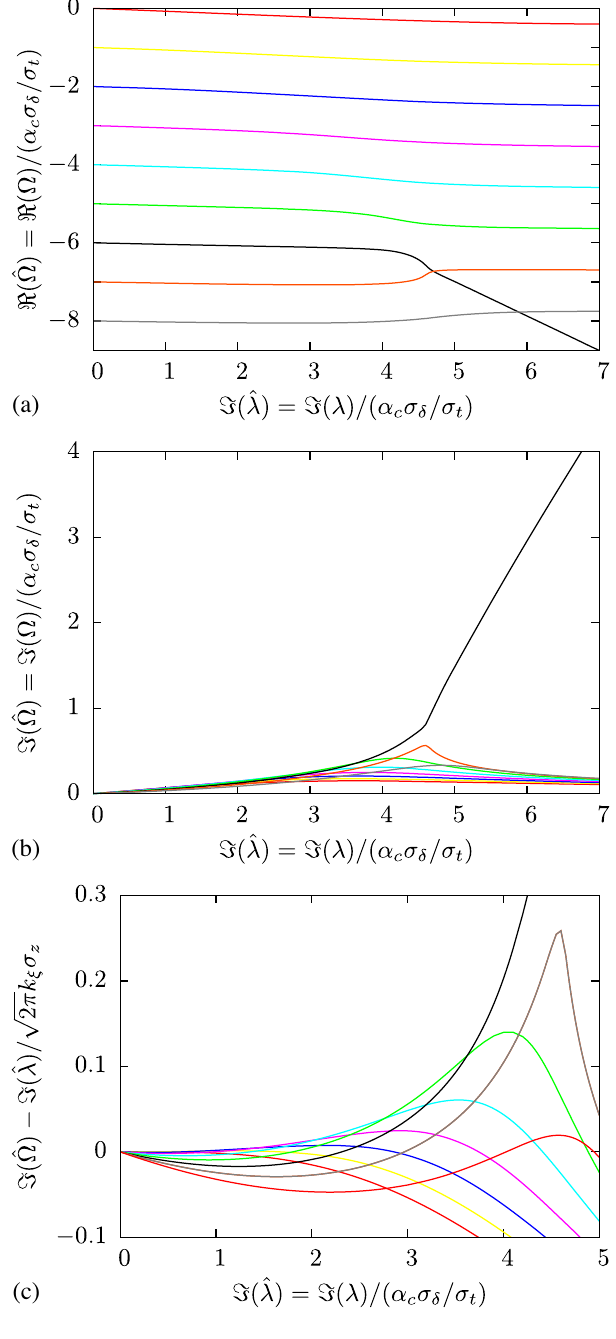
FIG. 2. Complex growth rate of the unstable modes when 6 . (a) plots the real part (frequency) of ˆ Ω for nine k ξ σ z ¼ different unstable modes, while (b) and (c) plot the correspond- ing growth